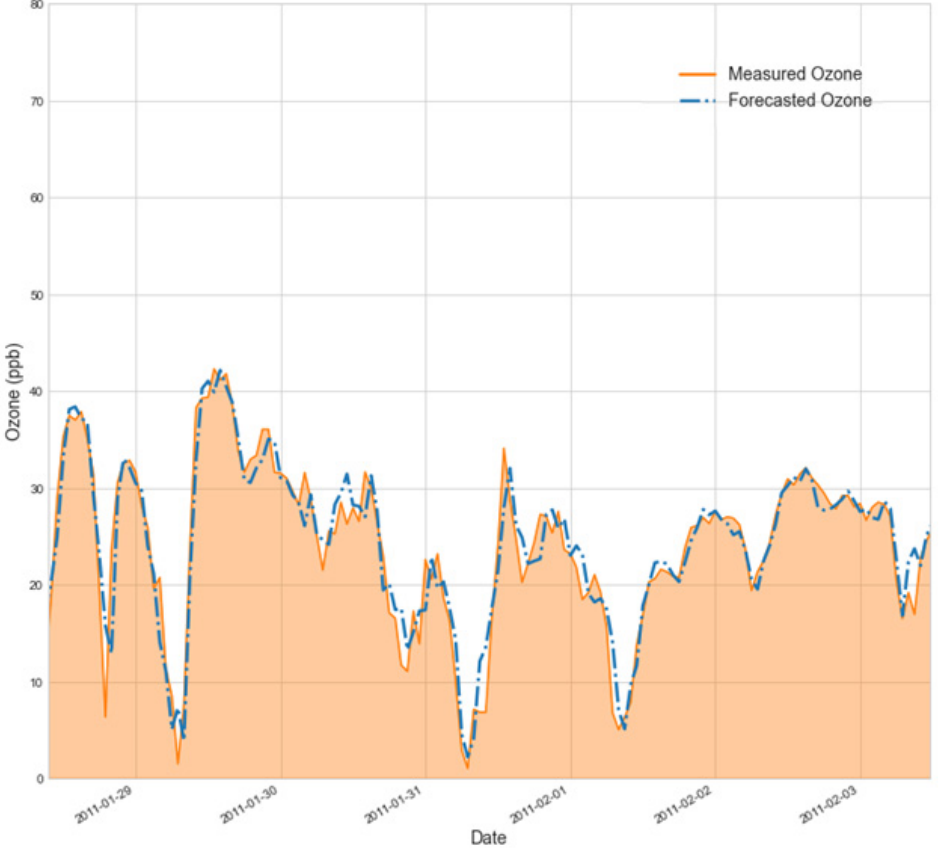
Figure 7. Comparison between forecast ozone values using GraphSAGE and validation dataset and actual measured concentrations for 1 h forecasting horizon.